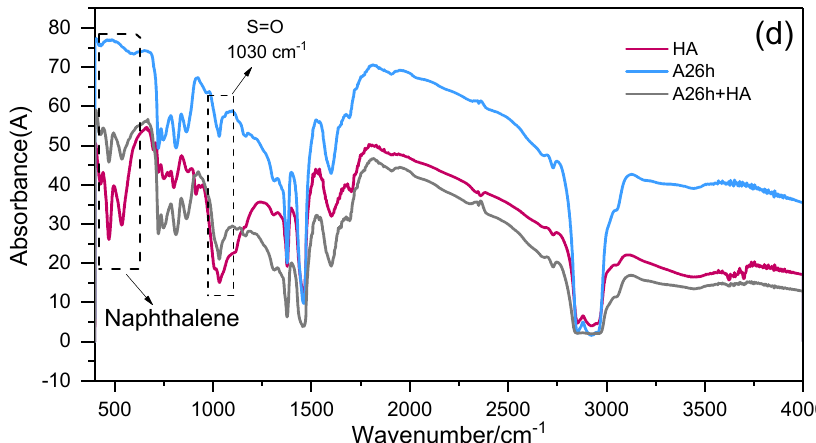
Figure 6. Fourier transform infrared (FTIR) spectra of virgin and aged asphalt binder samples: ( a ) VA, A12h, and A26h; ( b ) TLA, VA, and HA; ( c ) HA, A12h, and A12h + HA; ( d ) HA, A26h, and A26h + HA.